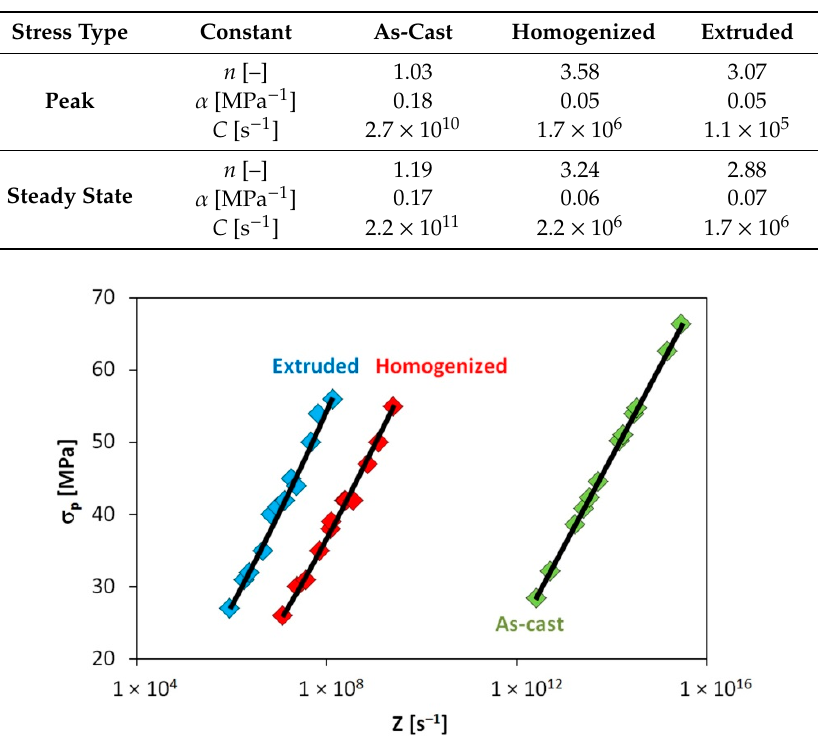
Figure 10. Influence of homogenization on the σ p values measured at different temperatures and selected strain rate values. Table 4. Constants in Equation (5) calculated for the individual initial structural states.